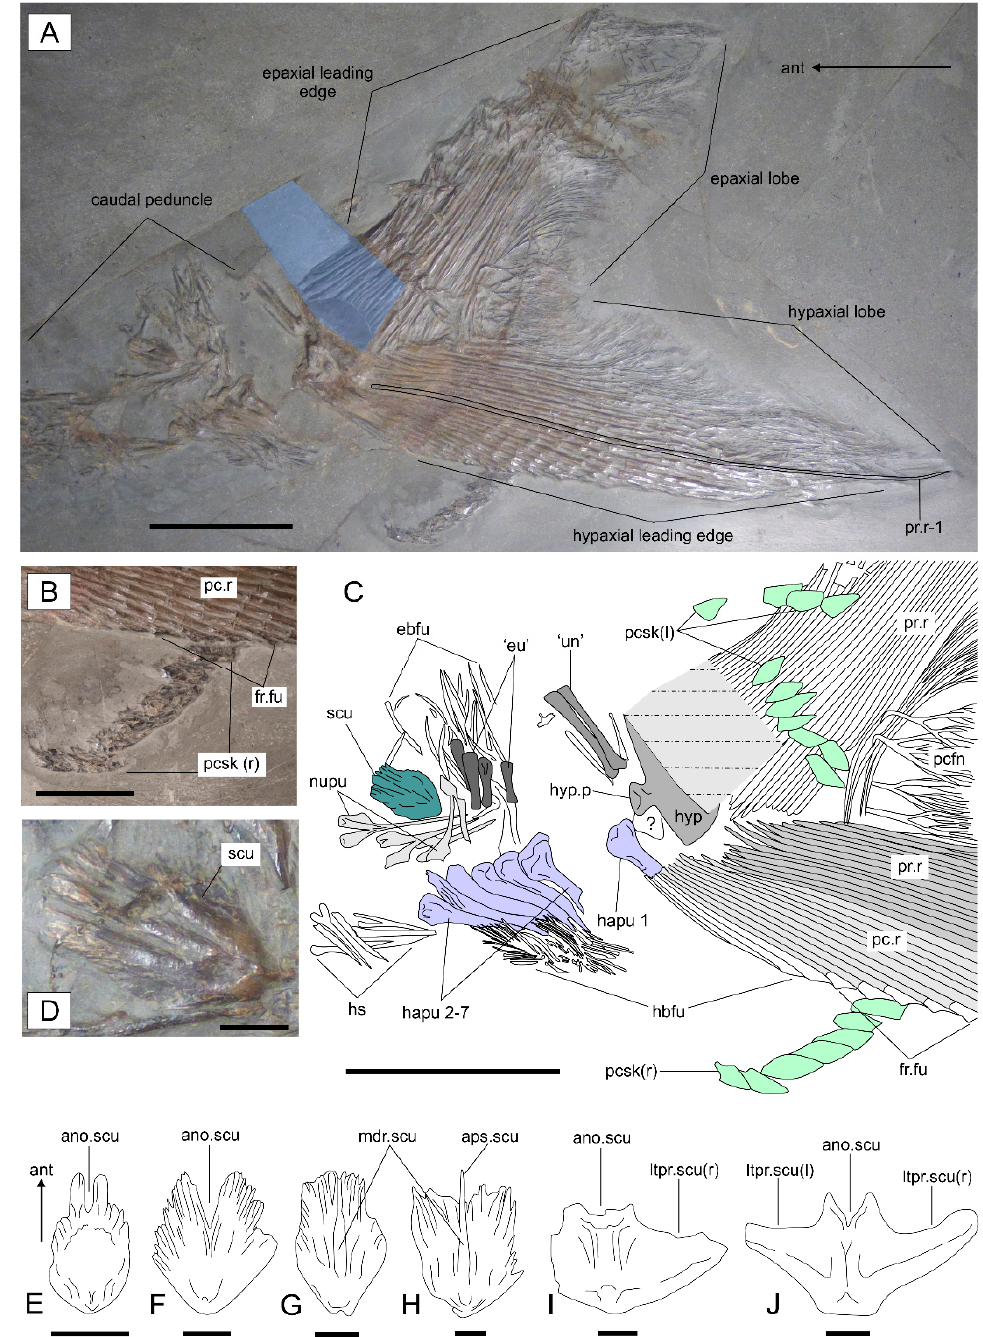
Figure 7. Caudal region of Germanostomus pectopteri gen. et sp. nov.: ( A ) holotype (SMNS 15815) in left lateral view. Areas of the specimen that have been reconstructed are shaded in blue. ( B ) Details of the right pre-caudal scaly keel and hypaxial fringing fulcra. ( C ) Line drawing of the caudal endoskeleton with shading and false colours indicating different pre-hypural elements and fin ray types. ( D ) Basal dorsal scute in external view showing characteristic anterior ornamentation and the medial dorsal ridge. Comparative line drawings of the basal dorsal scutes of closely related pachycormid taxa ( E – J ). ( E ) Saurostomus esocinus, neotype, immature individual (SMNS 51144); ( F ) Saurostomus esocinus , mature individual (SMNS 56982); ( G ) Germanostomus pectopteri gen. et sp. nov., holotype (SMNS 15815); ( H ) Ohmdenia multidentata, holotype (GPIT-PV-31531); ( I ) Martillichthys renwickae, holotype (NHMUK PV P 61563); ( J ) Asthenocormus titanius (L.1309; drawn from figure 7.4 in Reference [1]). ano.scu, anterior notch of the basal dorsal scute; aps.scu, anteriorly protruding spine of the dorsal